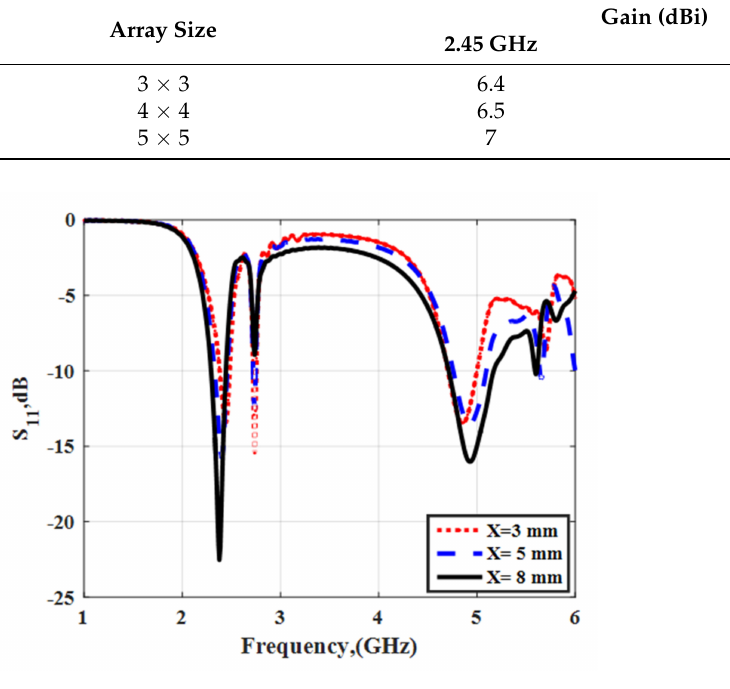
Figure 12. Simulated S 11 results of the proposed antenna with different space lengths (X) away from the antenna. Table 2. The effect of the cell separation (X) on the antenna gain. Cell Separation (X),